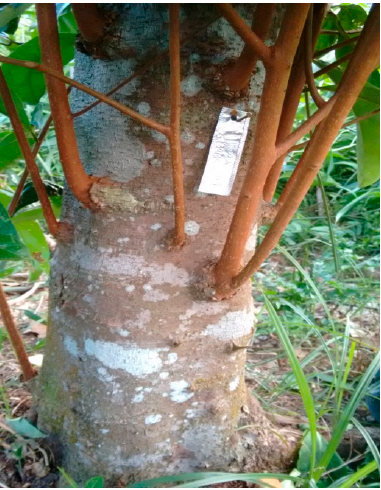
Figure A18. Spacing of shoots on a trunk cut 50 cm above the ground, the standard management form in Central Amazonian commercial rosewood plantations.